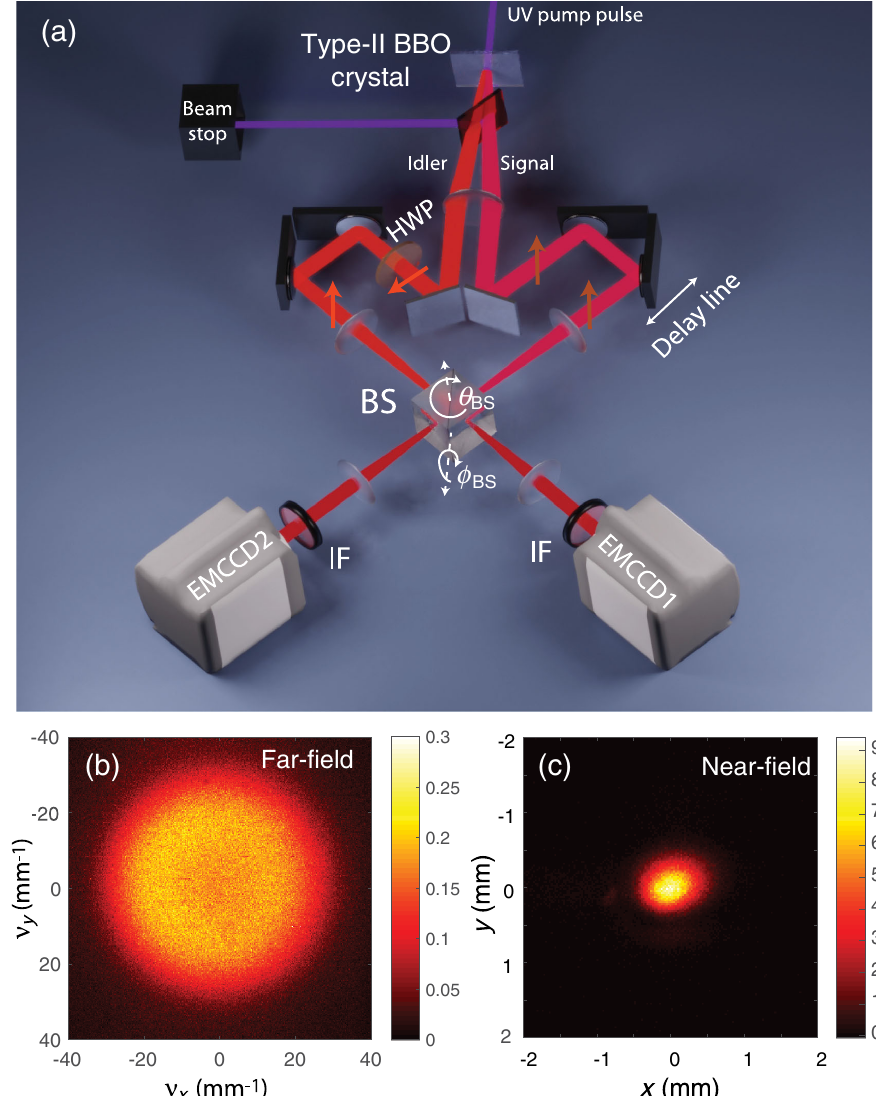
FIG. 1. (a) Experimental setup. (b,c) Average images in photon number of the far field and the near field of a single SPDC beam,